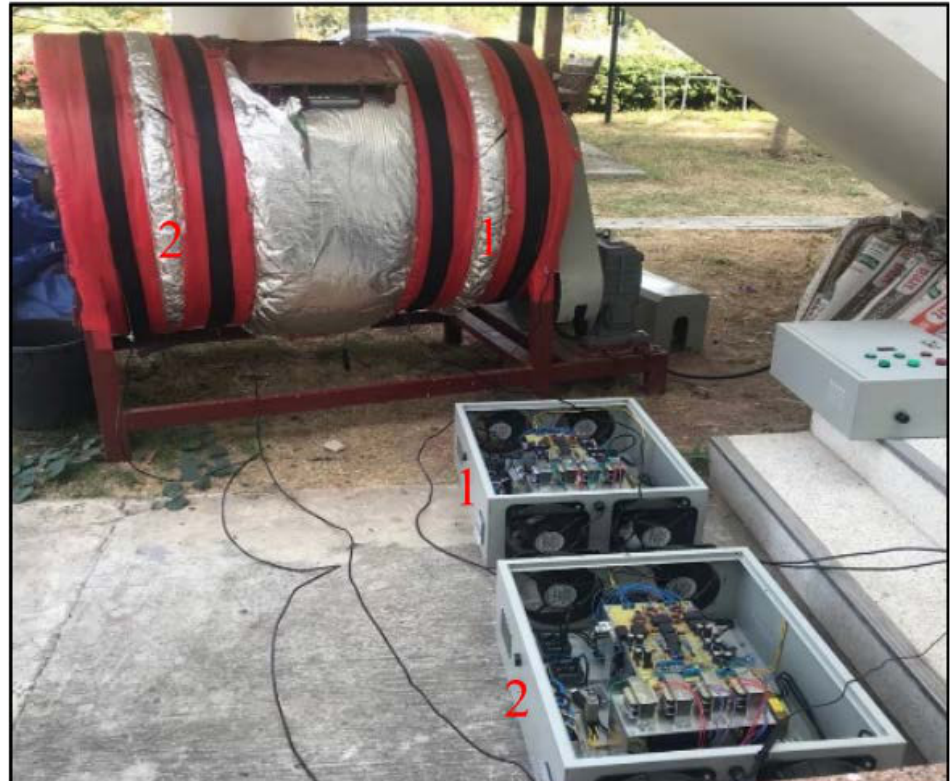
Figure 15. Both heat inductors are used to heat the bioreactor.